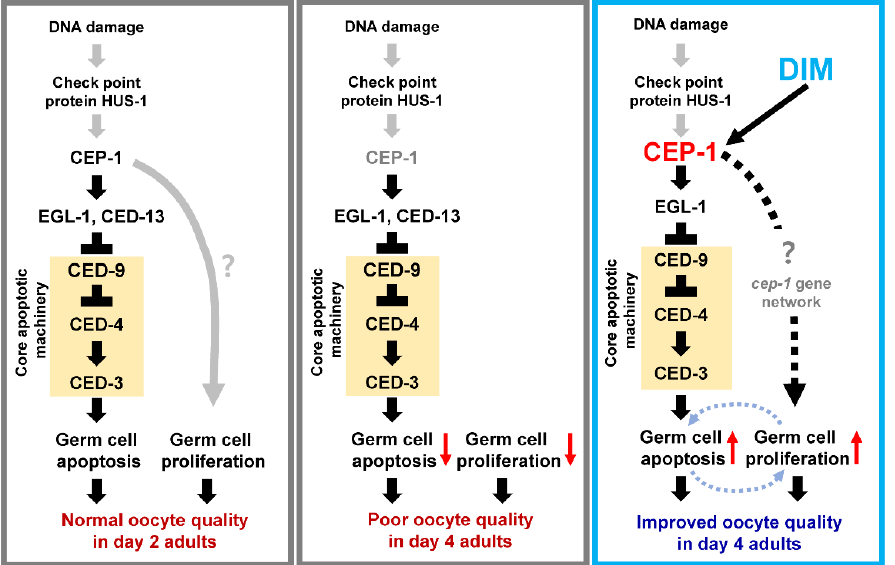
Figure 7. Working model: DIM supplementation maintains the level of GCA and GCP in the reproductively aged Caenorhabditis elegans germ line in the presence of CEP-1/p53 activity. GCA is mediated by CEP-1-EGL-1 pathway that inhibits CED-9 expression, which then activates core apoptotic machinery. Both GCA and GCP contribute to improving oocyte quality during reproductive aging.